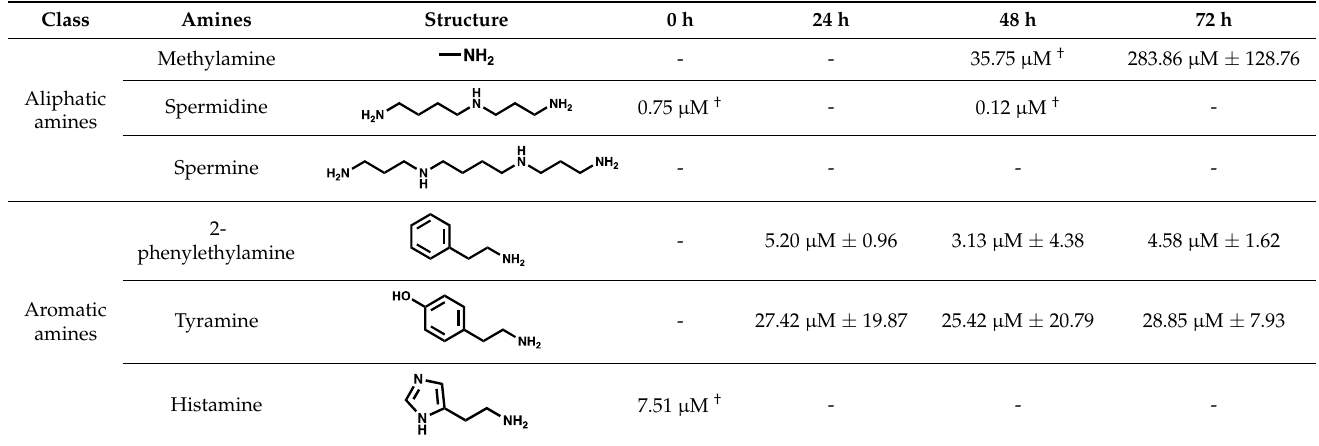
Table 1. Biogenic amines produced during the in vitro colonic simulation.